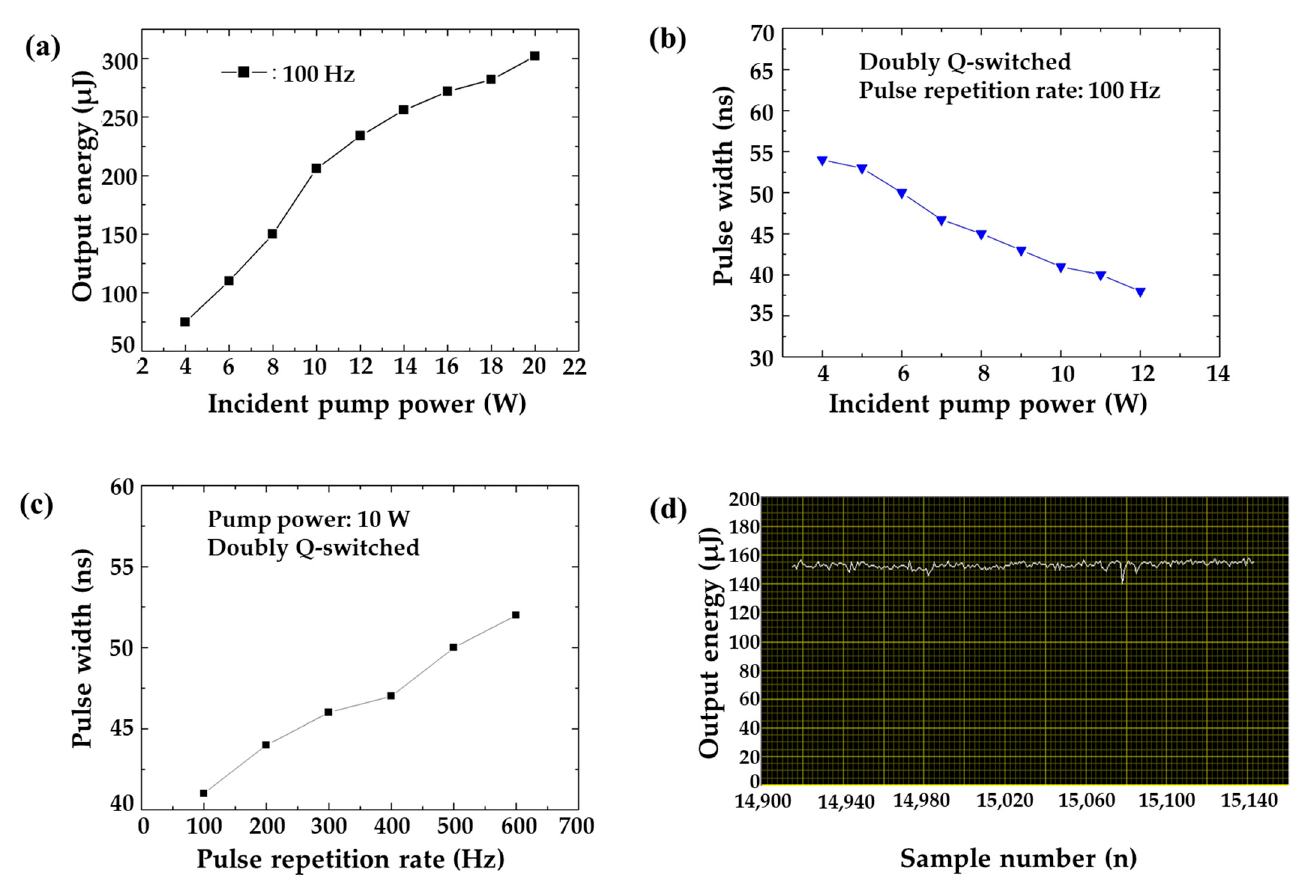
Figure 4. Characteristics of developed doubly Q-switched 1064 nm Nd:YAG laser. ( a ) Comparison of output energy according to incident pump power, ( b ) comparison of output pulse width according to incident pump power, ( c ) comparison of output pulse width according to pulse repetition rate, ( d ) stability of output energy, according to the sample numbers .